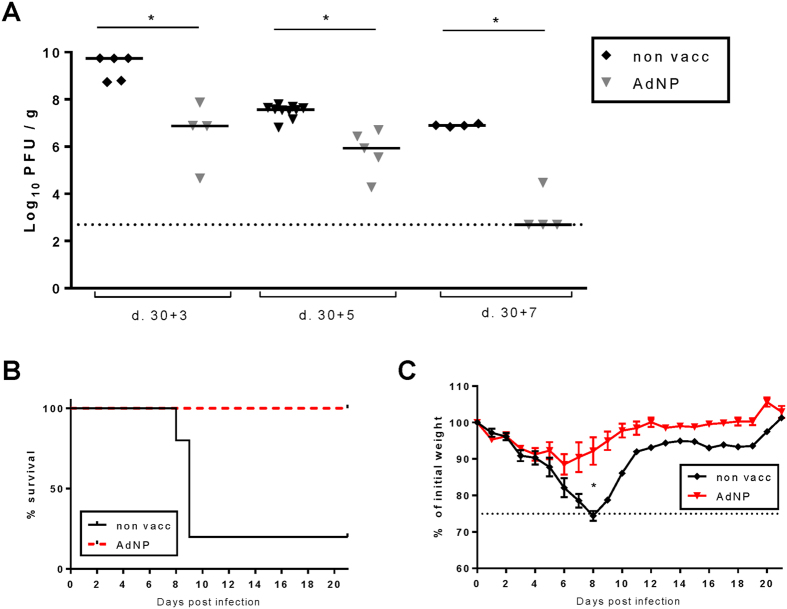
Conferred protection from immunization with AdNP.C57BL/6 mice were vaccinated subcutaneously with 2 × 107 PFU of AdNP and challenged with PR8 virus intranasally 30 days later. (A) Lungs were removed 3, 5 and 7 days post infection and viral titers were analysed using an MDCK plaque assay. Each dot represents one animal and lines represent medians. Dotted line represents the detection level for the assay. (B–C) Line graphs show survival (B) and percentages of initial body weight (C) as a function of time after challenge (5 animals per group). *p < 0.05.